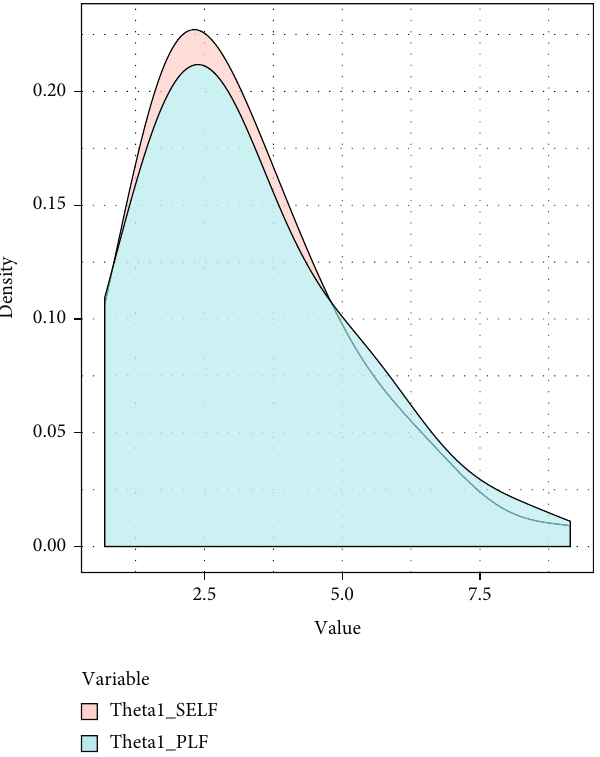
Figure 3: The marginal density for θ